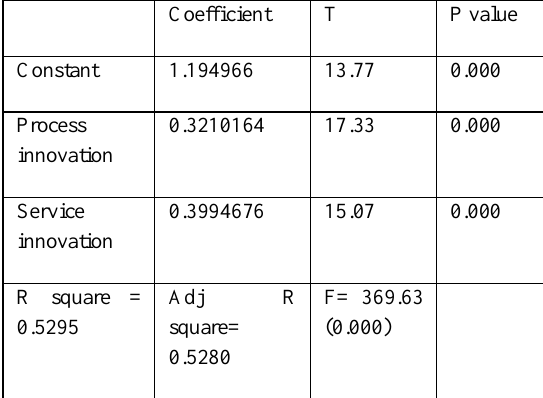
Table 3: Regression Result for Hypothesis